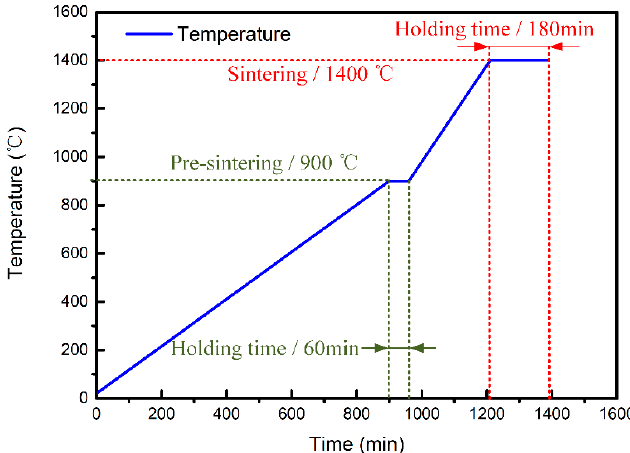
Figure 11. Temperature-time curve for pre-sintering and sintering processes.